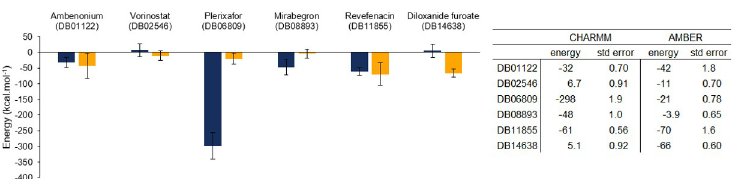
Fig 4. Binding energy on MM-PBSA calculation for the complexes. CHARMM is represented in blue and AMBER, in yellow. The error bars represents the standard error.